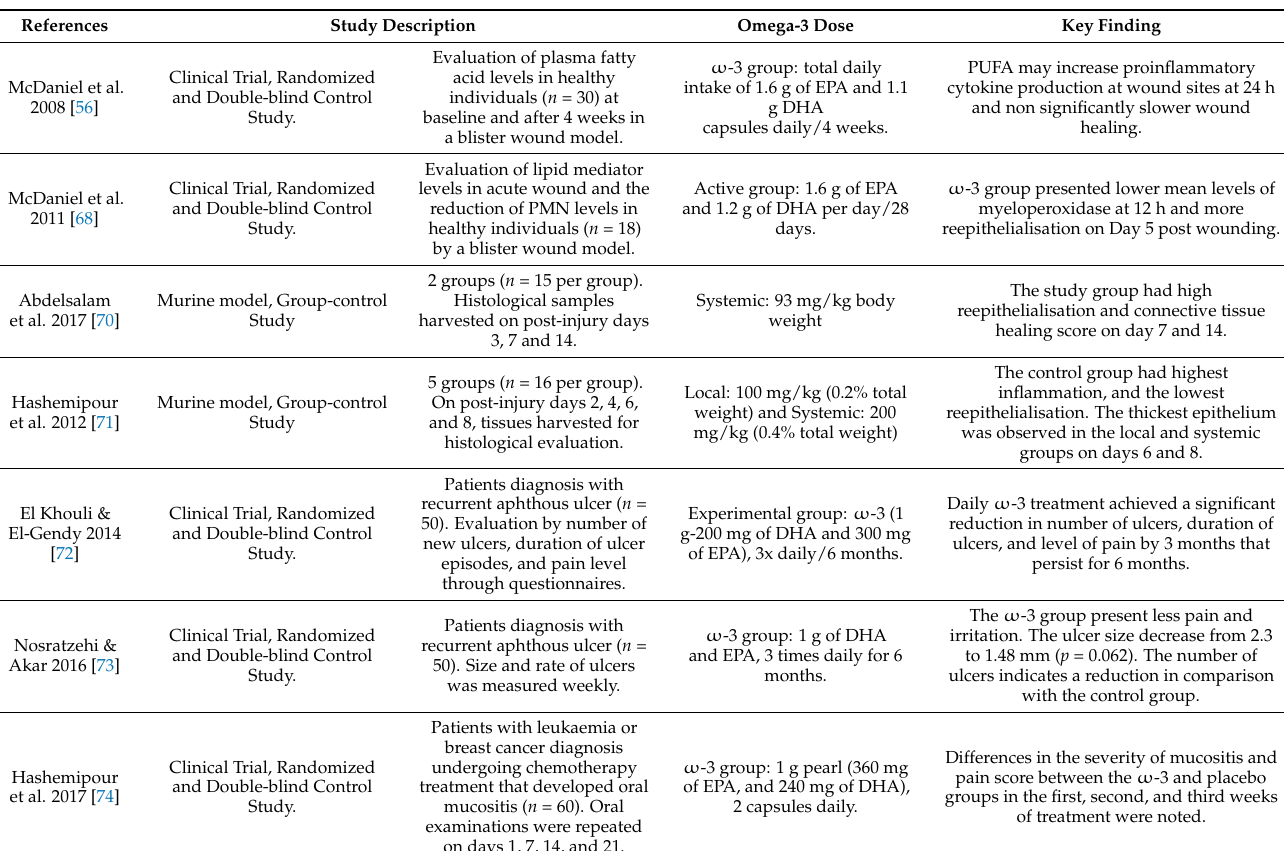
Table 1. Summary of the characteristics of studies investigating the effectiveness of omega-3 ( ω -3) PUFAS on different ulcers. Study Description Omega-3